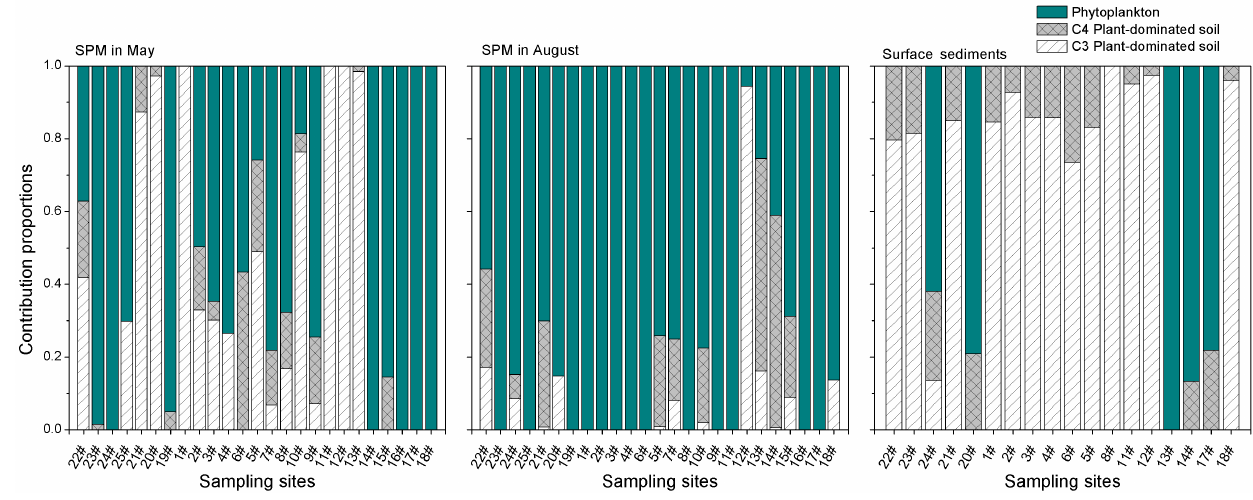
Figure 5. Contribution proportions of different sources to POC in suspended matters and surface